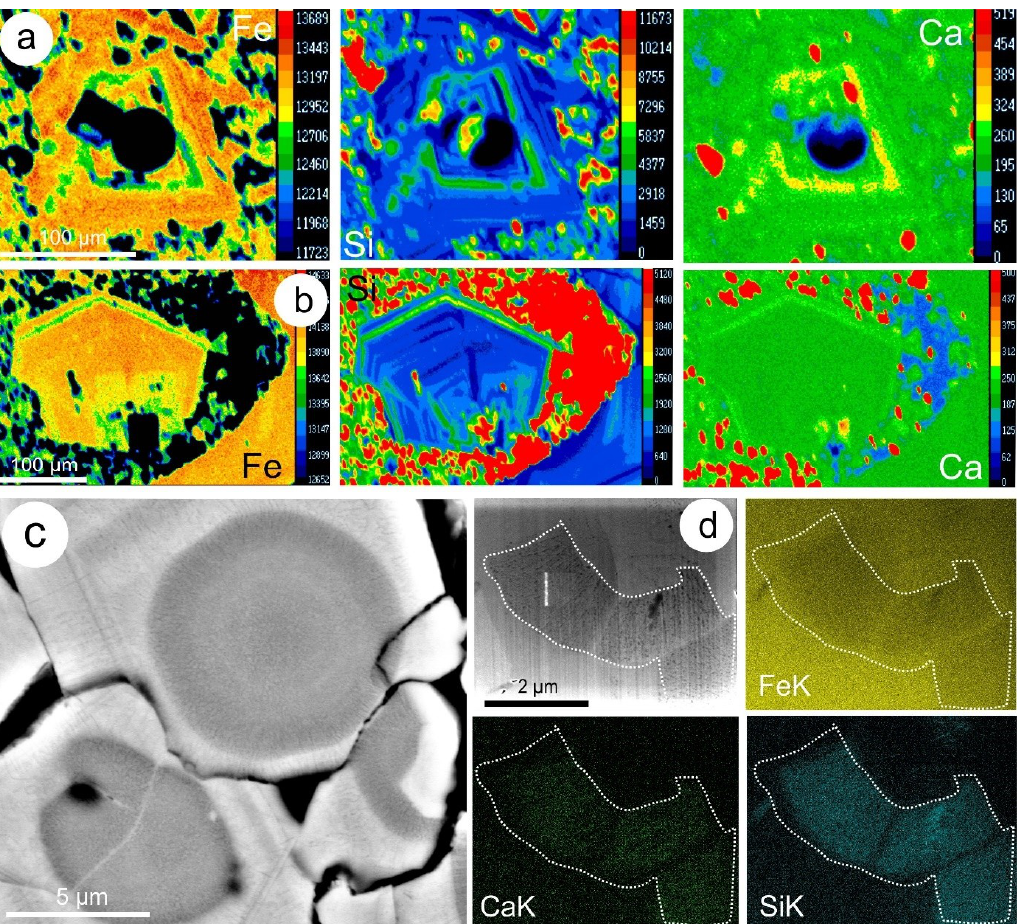
Figure 3. Element maps (EPMA in ( a , b ) and EDS-SEM (on the FIB platform) in (d)) and BSE image in ( c ) of medium-sized and small grains of silician magnetite (massive interval in location #1; drillhole RU65-7976). Note the continuous appearance of the Si along the bands in (a) and (b). Note the fine-mottled texture in ( c ) becomes apparent on the maps in ( d ) which are obtained from a FIB-prepared foil. This illustrates the differences in maps depending upon the sample thickness, i.e., from the surface of a polished block and from a <100 nm-thin foil in (a, b) and (d), respectively. Foils obtained from the medium-sized grains in the same sample (150–200 µm) show the crosscutting relationships between crystal zoning and inclusion trails (Figure 5a,b). The crystal zoning features compositional variation with respect to the element association of individual bands, some of which are Si-rich whereas others display a prominent 3-element (Si > Ca > Mg) association